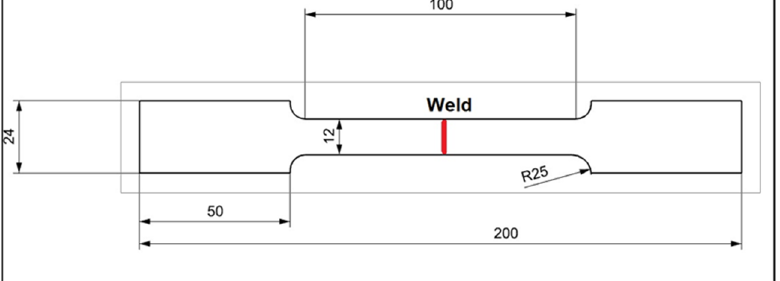
Figure 8. Schematic representation of tensile tested specimen (all dimensions in mm).